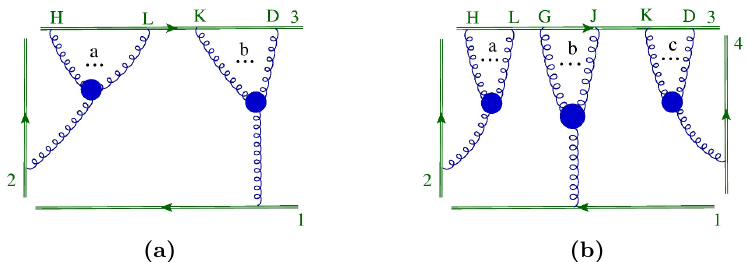
Figure 10. Cwebs having shuffle of a , b and c attachments at same